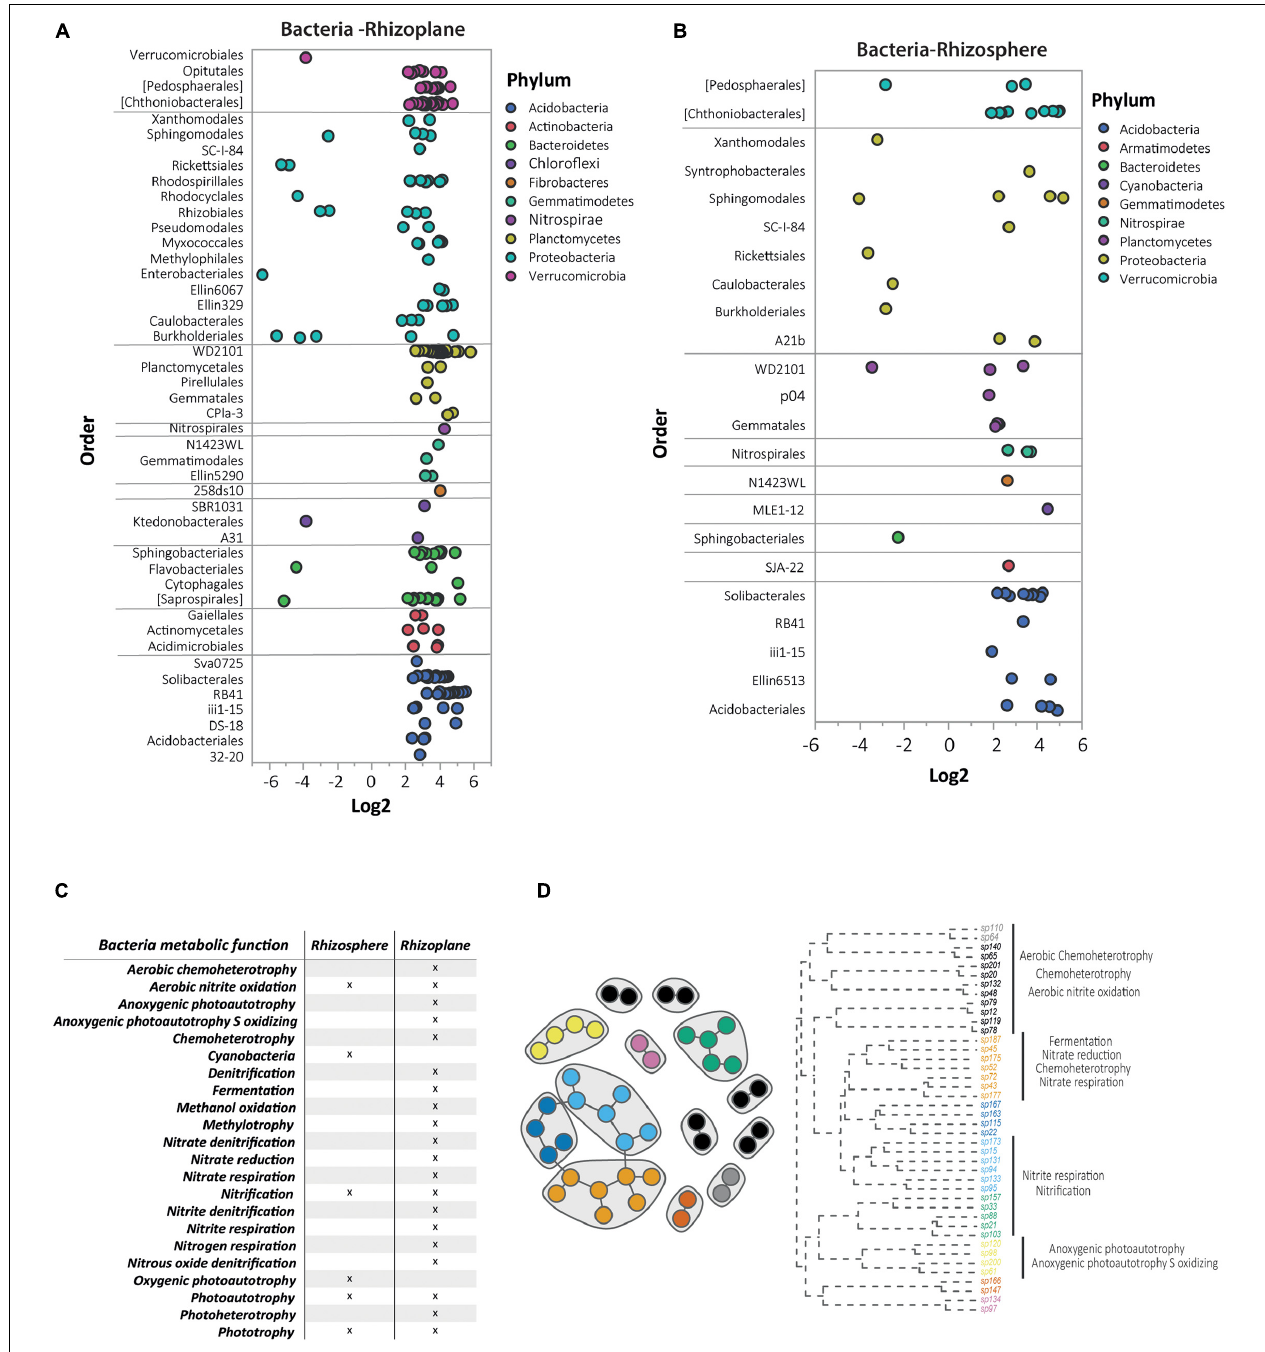
FIGURE 6 | Differential abundance analysis (DAA) and metabolic functions of bacterial OTUs in N. brachypetala and non-hyperaccumulator species. Bubble plots of the differential abundant bacterial OTUs on the rhizoplane (A) and rhizosphere (B). The x axis indicates the log2 ratio (hyperaccumulators vs. non-hyperaccumulators). The y axis indicates bacteria at the taxonomical level of order. Bubble colors indicate the associated phylum. (C) The co-occurrence network of the DAA bacterial OTUs in the rhizoplane of N. brachypetala and a dendrogram with the annotated functions. (D) Table of metabolic functions of the DAA bacteria in N. brachypetala in each root